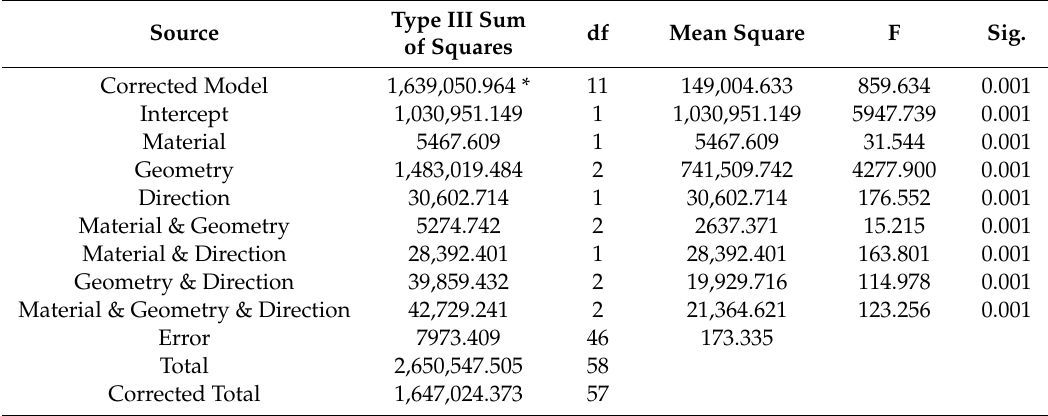
Table 4. Results of the ANOVA analysis for breaking force.